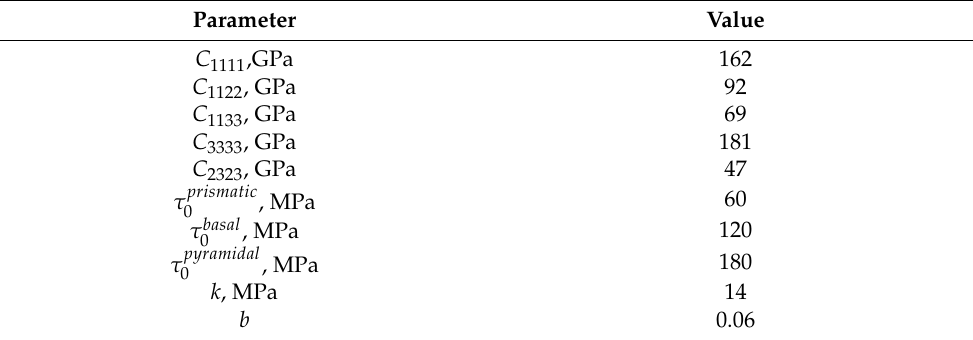
Table 1. Material constants and model parameters [6,